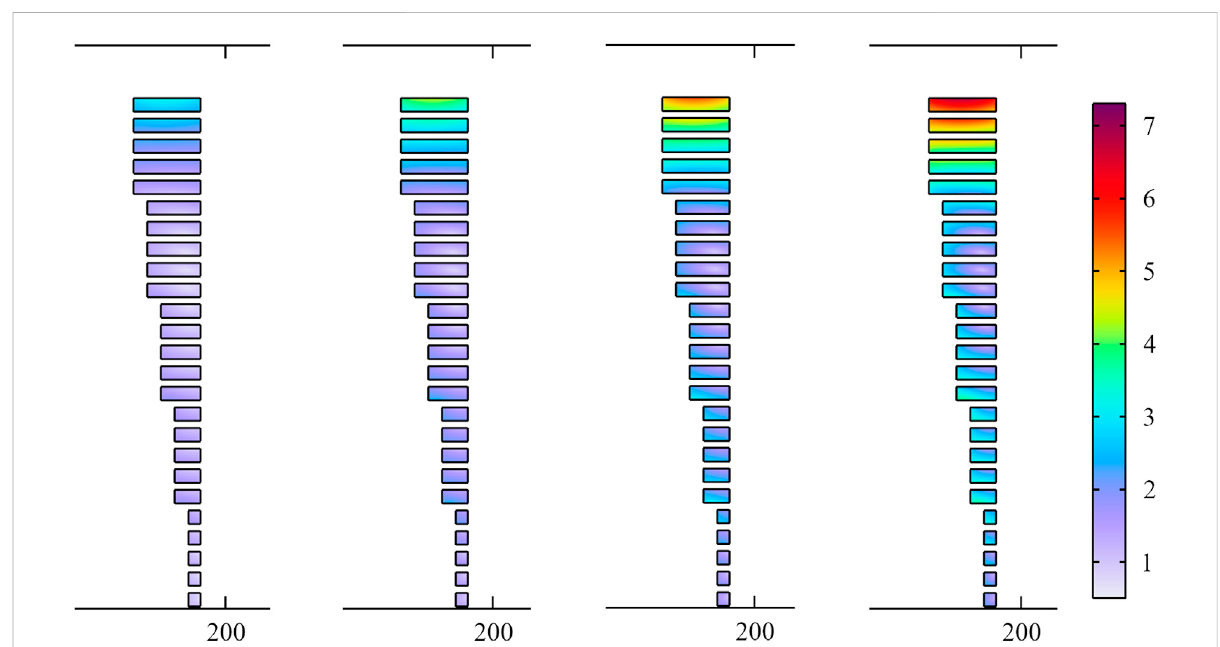
FIGURE 8 The J / J c distribution of solenoid magnet with inverted trapezoidal cross-section while the carried current is 100, 120, 140 and 160 A.